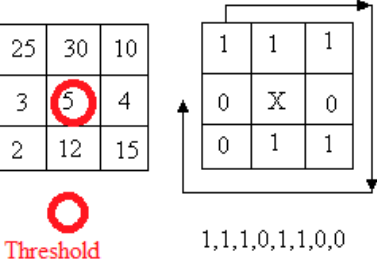
Figure 1. Example of abasic LBP operator.